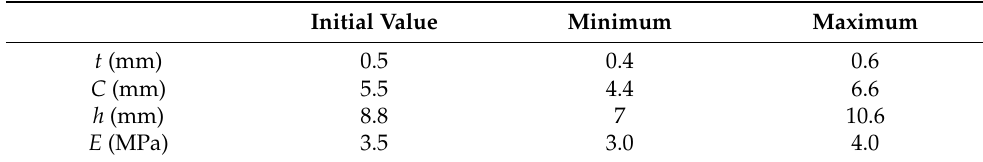
Table 2. Values of structural parameters in simulation analysis.